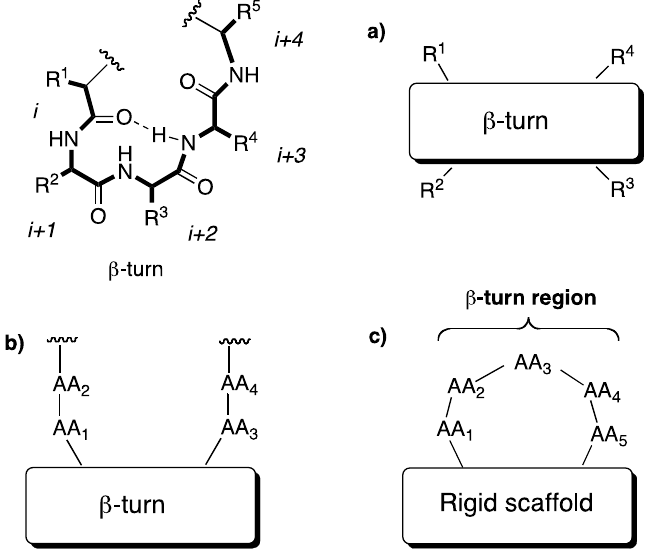
Figure 4. β -turn and induced β -turn. ( a ) internal β -turn mimics; ( b ) β -hairpin mimics (in which a rigid scaffold induces reversal of the peptide chain); ( c ) external β -turn inducers.